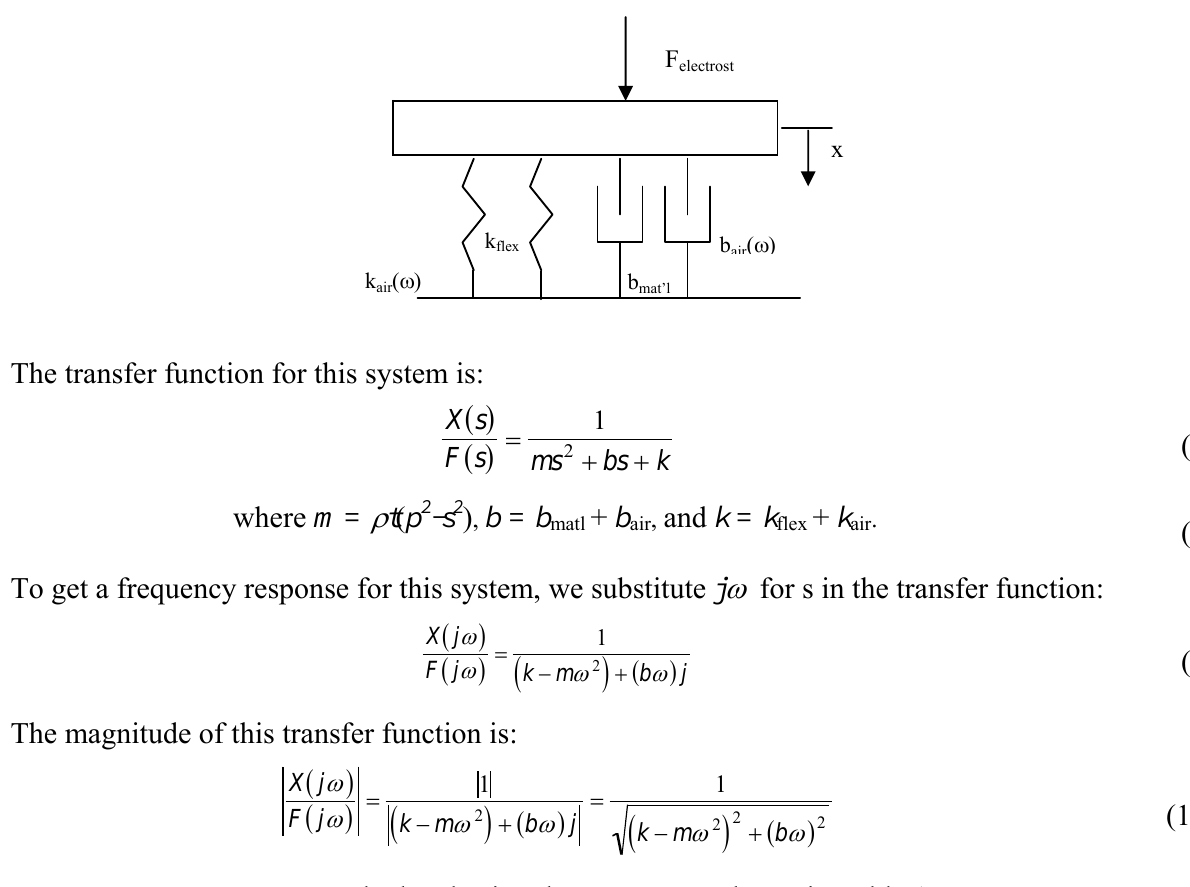
Figure 2. Lumped parameter model of electrostatic actuator with squeeze film damping.